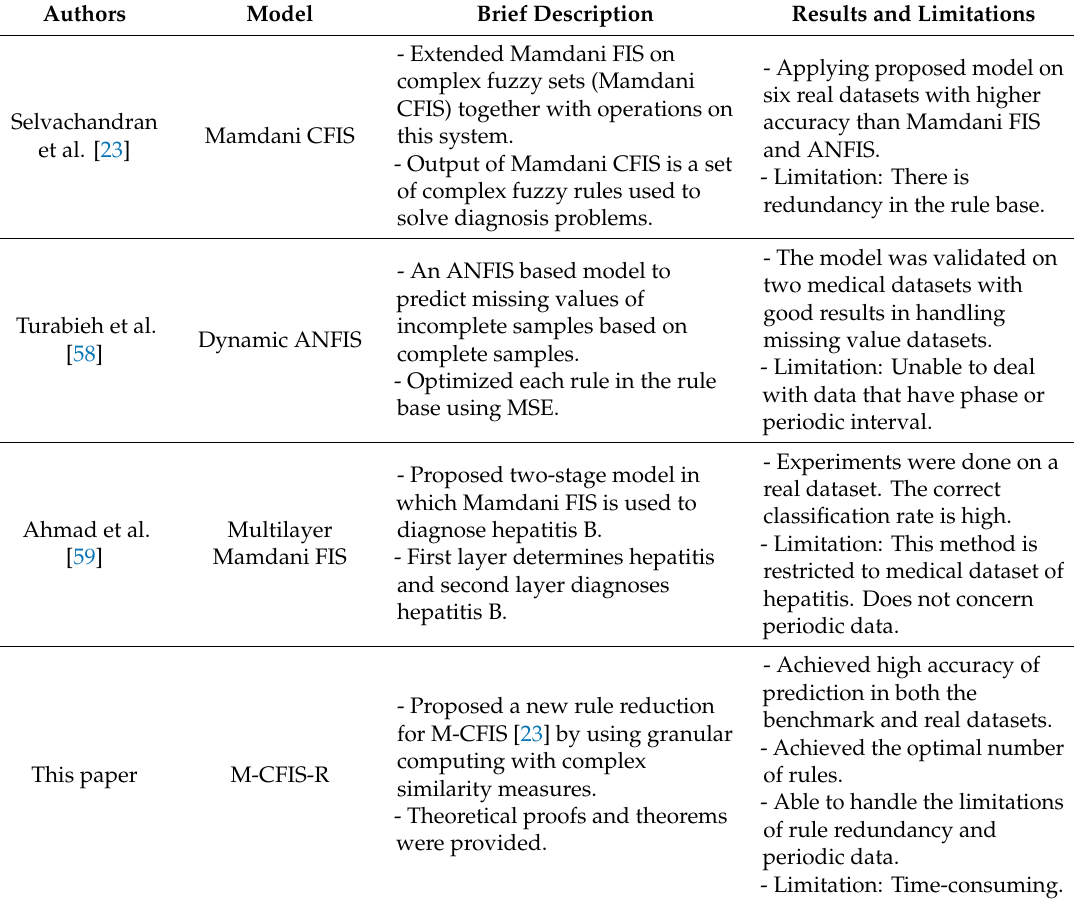
Table 5. Theoretical comparison between the proposed work and